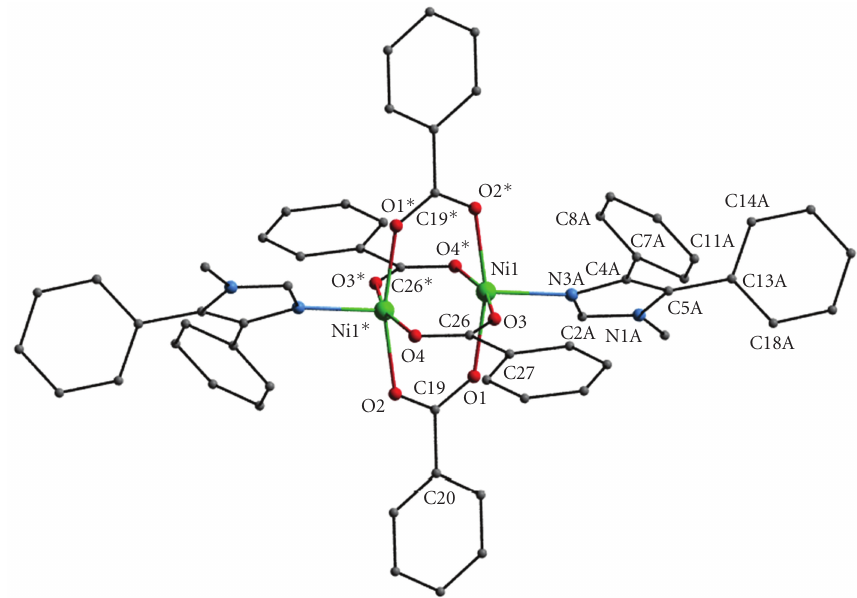
Figure 2: A partially labeled plot of the dinuclear complex 2 · 2MeCN. The acetonitrile molecules and the hydrogen atoms have been omitted for clarity. Asterisks are used for symmetry related (1 / 2 − x , 1 / 2 − y , 1 − z ) atoms.